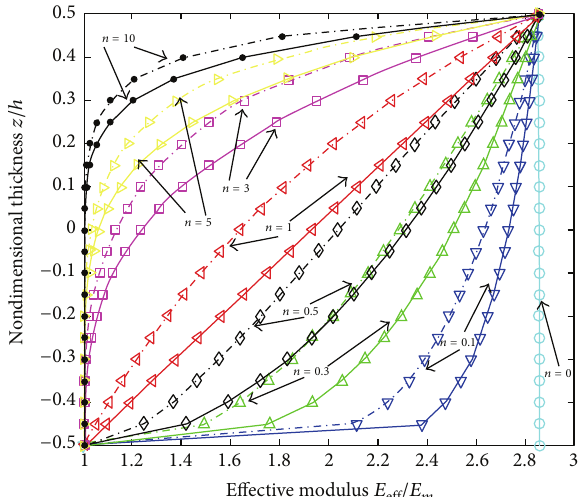
Figure 2: The effective modulus of Al/ZrO 2 FGM plate computed by the rule of mixture (in solid line) and the Mori-Tanaka model (in dash dot line)